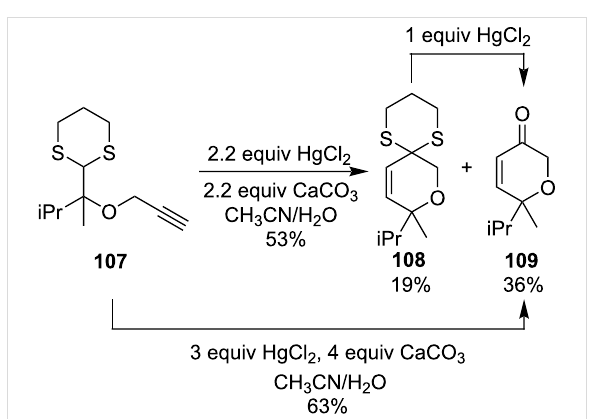
Scheme 32: Hg(II)-salt-promoted cyclization–rearrangement to form heterocyclic